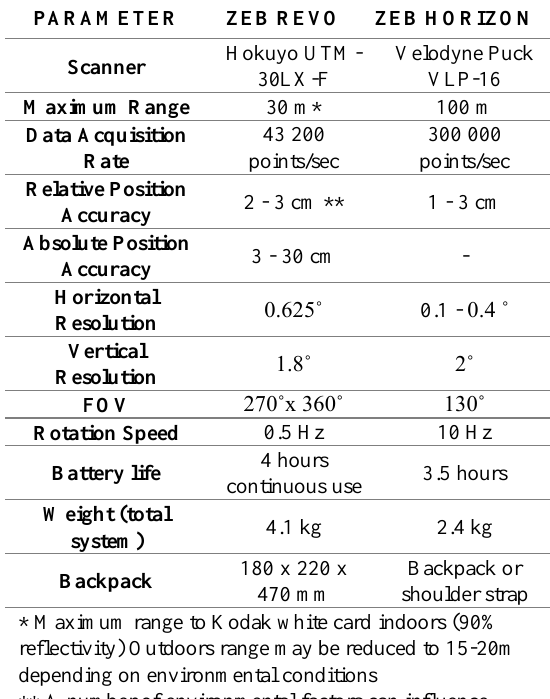
Table 2. Technical specifications of ZEB REVO and ZEB